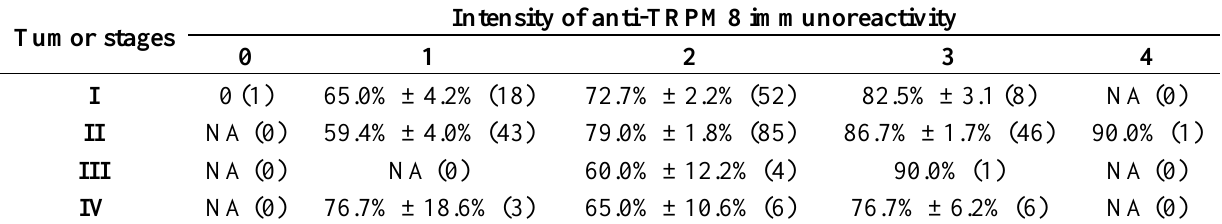
Table 3. The percent coverage ± standard error for expression of TRPM8 in pancreatic adenocarcinoma with respect to the intensity and the tumor stage. The numbers in parentheses represent the patient counts. NA, not